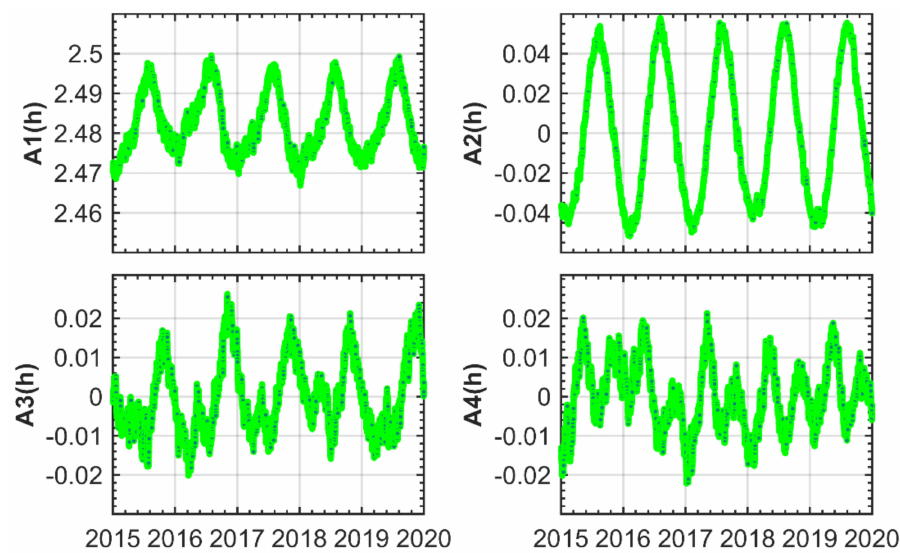
Figure 1. Time series of the first four orders correlation coefficient from 2015 to 2019. The resolution of the time series is 1-h, and the width of each gray grid is one year in the x -axis direction.